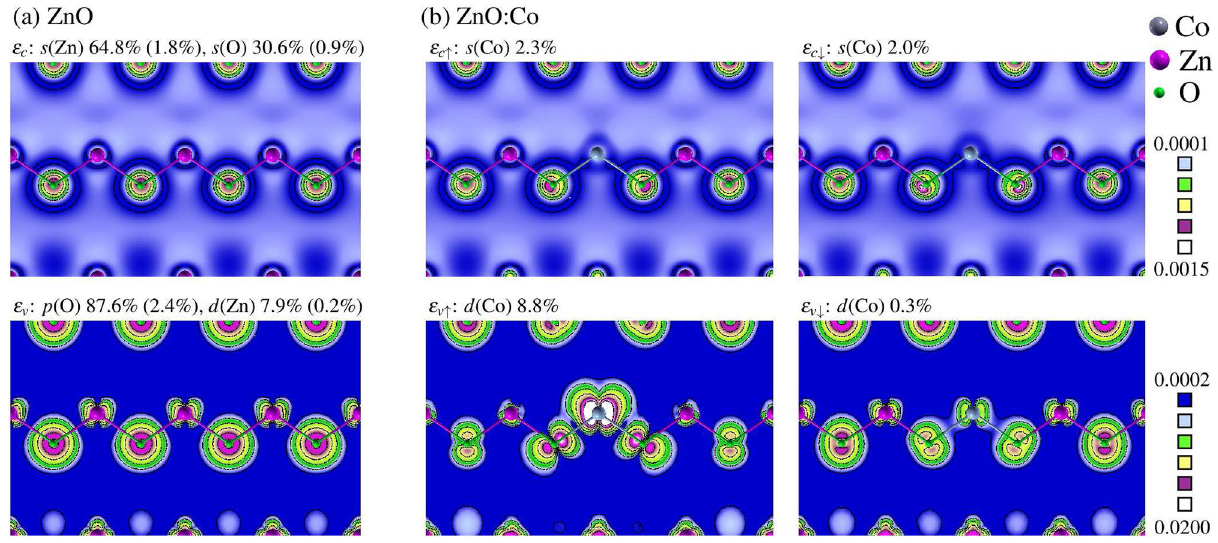
Figure 4. ( a ) The wave functions squared of the CBM and the VBM (sum over p states) of ZnO and their orbital compositions. The numbers give the total contribution of orbitals, and in parentheses we give the contribution per one cation or one anion in the 72-atom supercell (e.g., 1.8% × 36 = 64.8% ). ( b ) The wave functions squared of the CBM and the VBM of ZnO:Co 2+ . Left (right) panels show the spin-up (spin-down) states. The contributions of s (Co) or d (Co) orbitals are shown in each